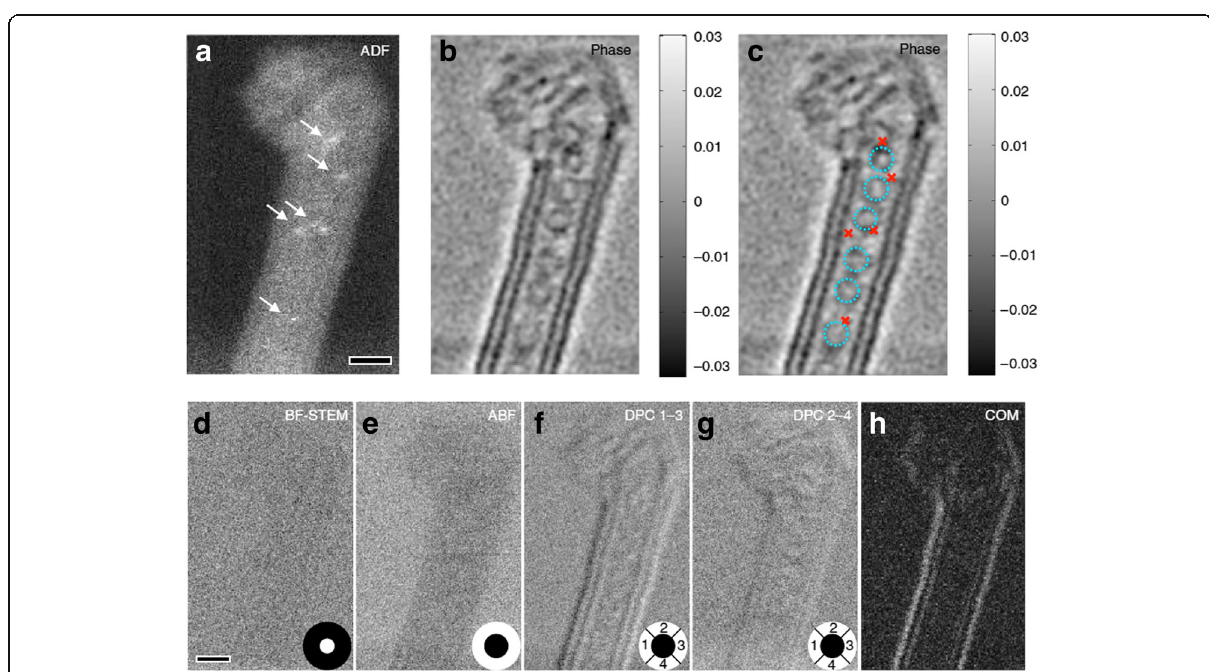
Fig. 8 Simultaneous Z-contrast and phase images of a double-wall carbon nanotube peapod. a Incoherent Z-contrast ADF image clearly shows the locations of the single iodine atoms indicated by the arrows. b The reconstructed phase image shows the presence of fullerenes inside the nanotube. c Annotated phase image with the fullerenes labeled using dotted circles and iodine atoms labeled using cross marks based on their locations in the ADF image. It is clear that the iodine atoms are located close to but outside the fullerenes. For comparison, conventional phase-contrast images including BF, ABF, DPC, and the DPC using the center of mass approach were synthesized from the data and shown in d – h , respectively. The detector area of each imaging method is shown in white color in d – g . The experiment was performed at an electron probe current of ~ 2.8 pA, pixel dwell time of 0.25 ms and a dose of ~ 1.3 10 4 e Å − 2 . Scale bar, 1 nm; the gray scale of the phase in b is in units of radians reproduced from Rutte et al. 2016